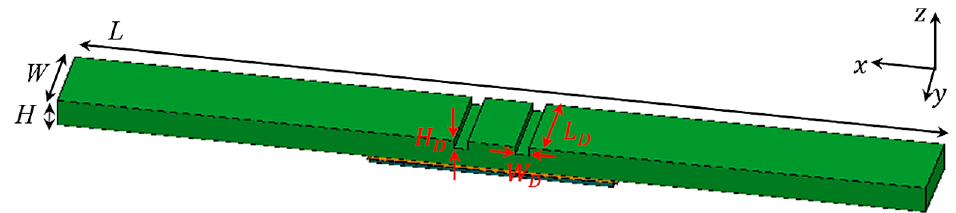
Figure 3. Simulation setup in FEKO for the assessment of defects in dielectric materials.